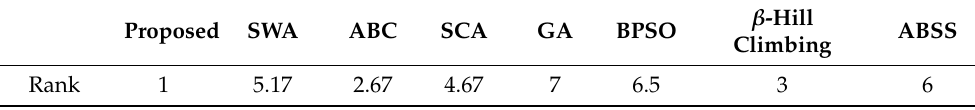
β -Hill ABSS Climbing